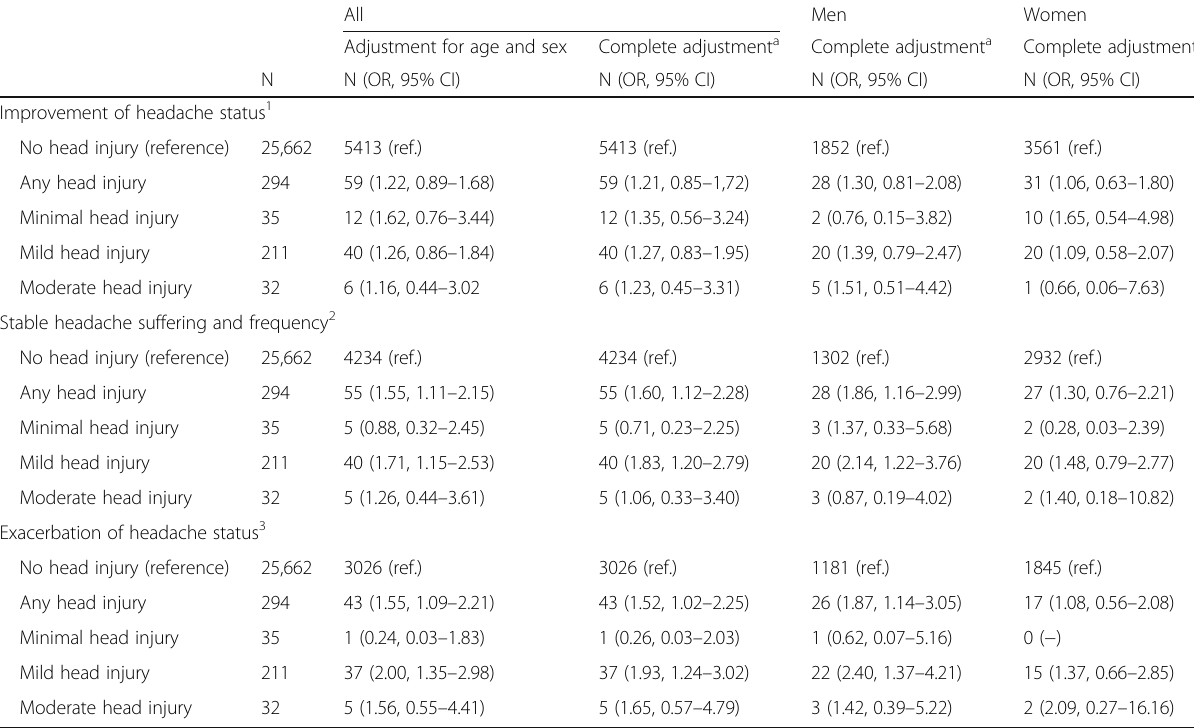
Table 4 Multivariate regression analyses of the associations between head injury and relative headache status in HUNT3 versus HUNT2 with regard both to suffering from headache as well as to change in headache frequency